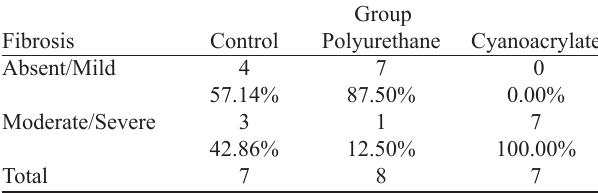
Table 2. Percentage of fibrosis in groups I, II, and III.